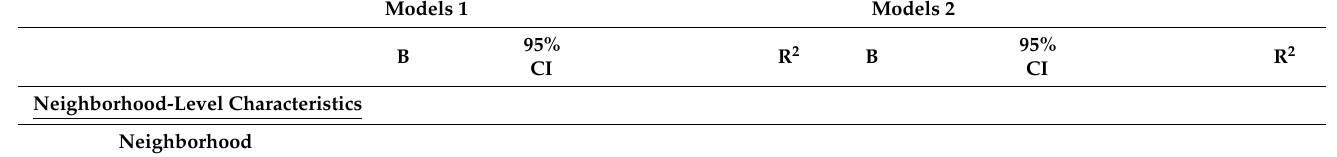
Table 2. Coefficients from regression models predicting 2-h glucose; bivariate associations and associations net individual/household covariates Latino youth ( n = 133), 2013–2015. Models